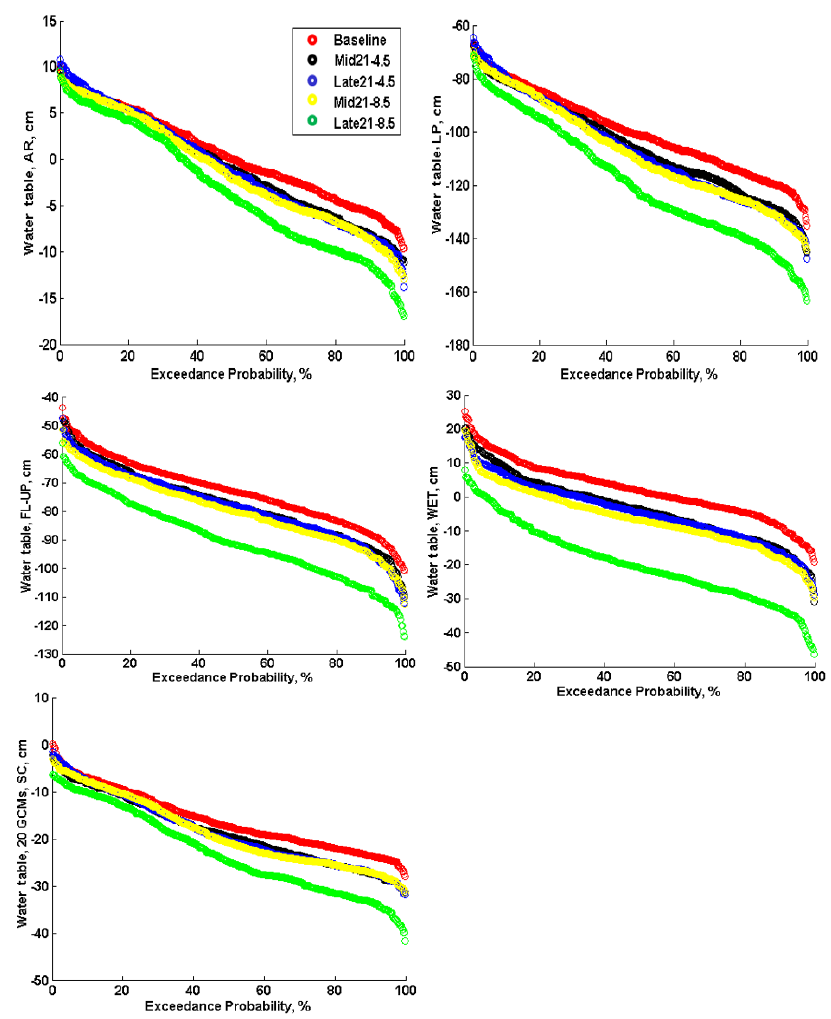
Figure 6. Exceedance probability of the mean predicted water table in the growing season of 20 GCMs in five wetlands in the SE United States (unit: cm), where the baseline is 1980–1999, the historical run of GCMs; mid21 is 2040–2059, under the RCPs 4.5 and 8.5 scenarios; late21 is 2080–2099, under the RCPs 4.5 and 8.5